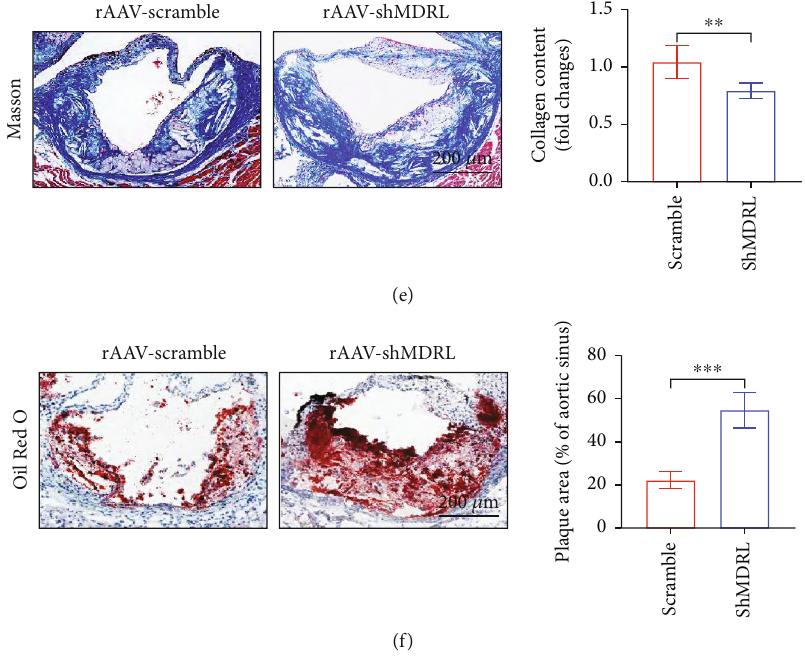
Figure 2: MDRL alleviates atherosclerosis in LDLR -/- mice fed with HFD. (a) Representative images of HE-stained aortic roots from rAAV- CTR- or rAAV-MDRL-treated LDLR -/- mice and quanti fi cation of fi brous cap thickness. (b) Representative images of Masson-stained aortic roots from rAAV-CTR- or rAAV-MDRL-treated LDLR -/- mice and quanti fi cation of collagen content. (c) Representative images of Oil red O-stained aortic roots from rAAV-CTR- or rAAV-MDRL-treated LDLR -/- mice and quanti fi cation of plaque area. (d) Representative images of HE-stained aortic roots from rAAV-scramble- or rAAV-shMDRL-treated LDLR -/- mice and quanti fi cation of fi brous cap thickness. (e) Representative images of Masson-stained aortic roots from rAAV-scramble- or rAAV-shMDRL-treated LDLR -/- mice and quanti fi cation of collagen content. (f) Representative images of Oil red O-stained aortic roots from rAAV-scamble- or rAAV-MDRL-treated LDLR -/- mice and quanti fi cation of plaque area. Scale bar: 200 μ m. Data are presented as mean ± SEM. ∗ P < 0 : 05 , ∗∗ P < 0 : 01 , ∗∗∗ P < 0 : 001 vs rAAV- CTR or rAAV-scramble